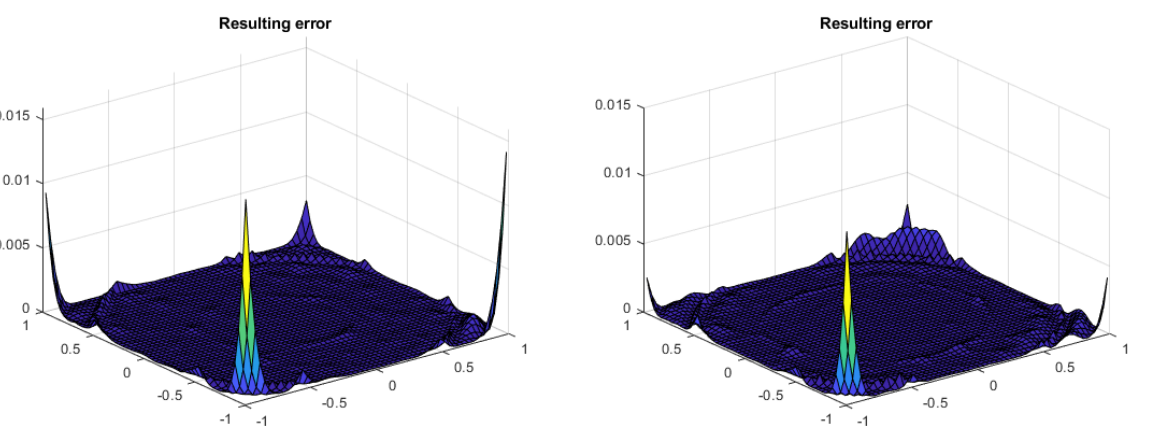
Figure 10. Unified worst learned patterns cos(φ) on the ( left ) and | 𝜕𝐿𝑜𝑠𝑠 𝜕𝑊 𝑛 | relationship to the average | 𝜕𝐿𝑜𝑠𝑠 𝜕𝑊 𝑛 | on the ( right ) for the dynamic alpha and drop-out modifications used together. In the case of the best learned cases, the behavior is similar to the previous cases. Figure 11 shows how it is similar to the dynamic alpha-only or dynamic drop-out-only cases. After seen the obtained results, it can be said that the combined methods make the network learn better than the case of standard SGD is used in the training, and they make all the patterns more relevant to the training process.